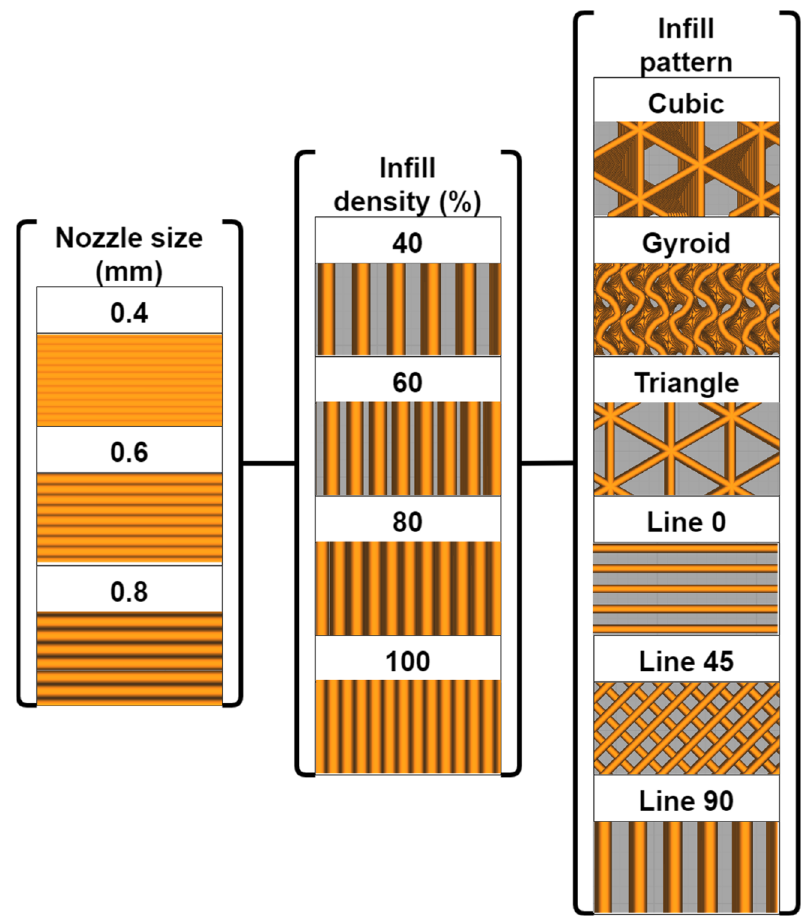
Figure 2. Process parameter levels and schematic.